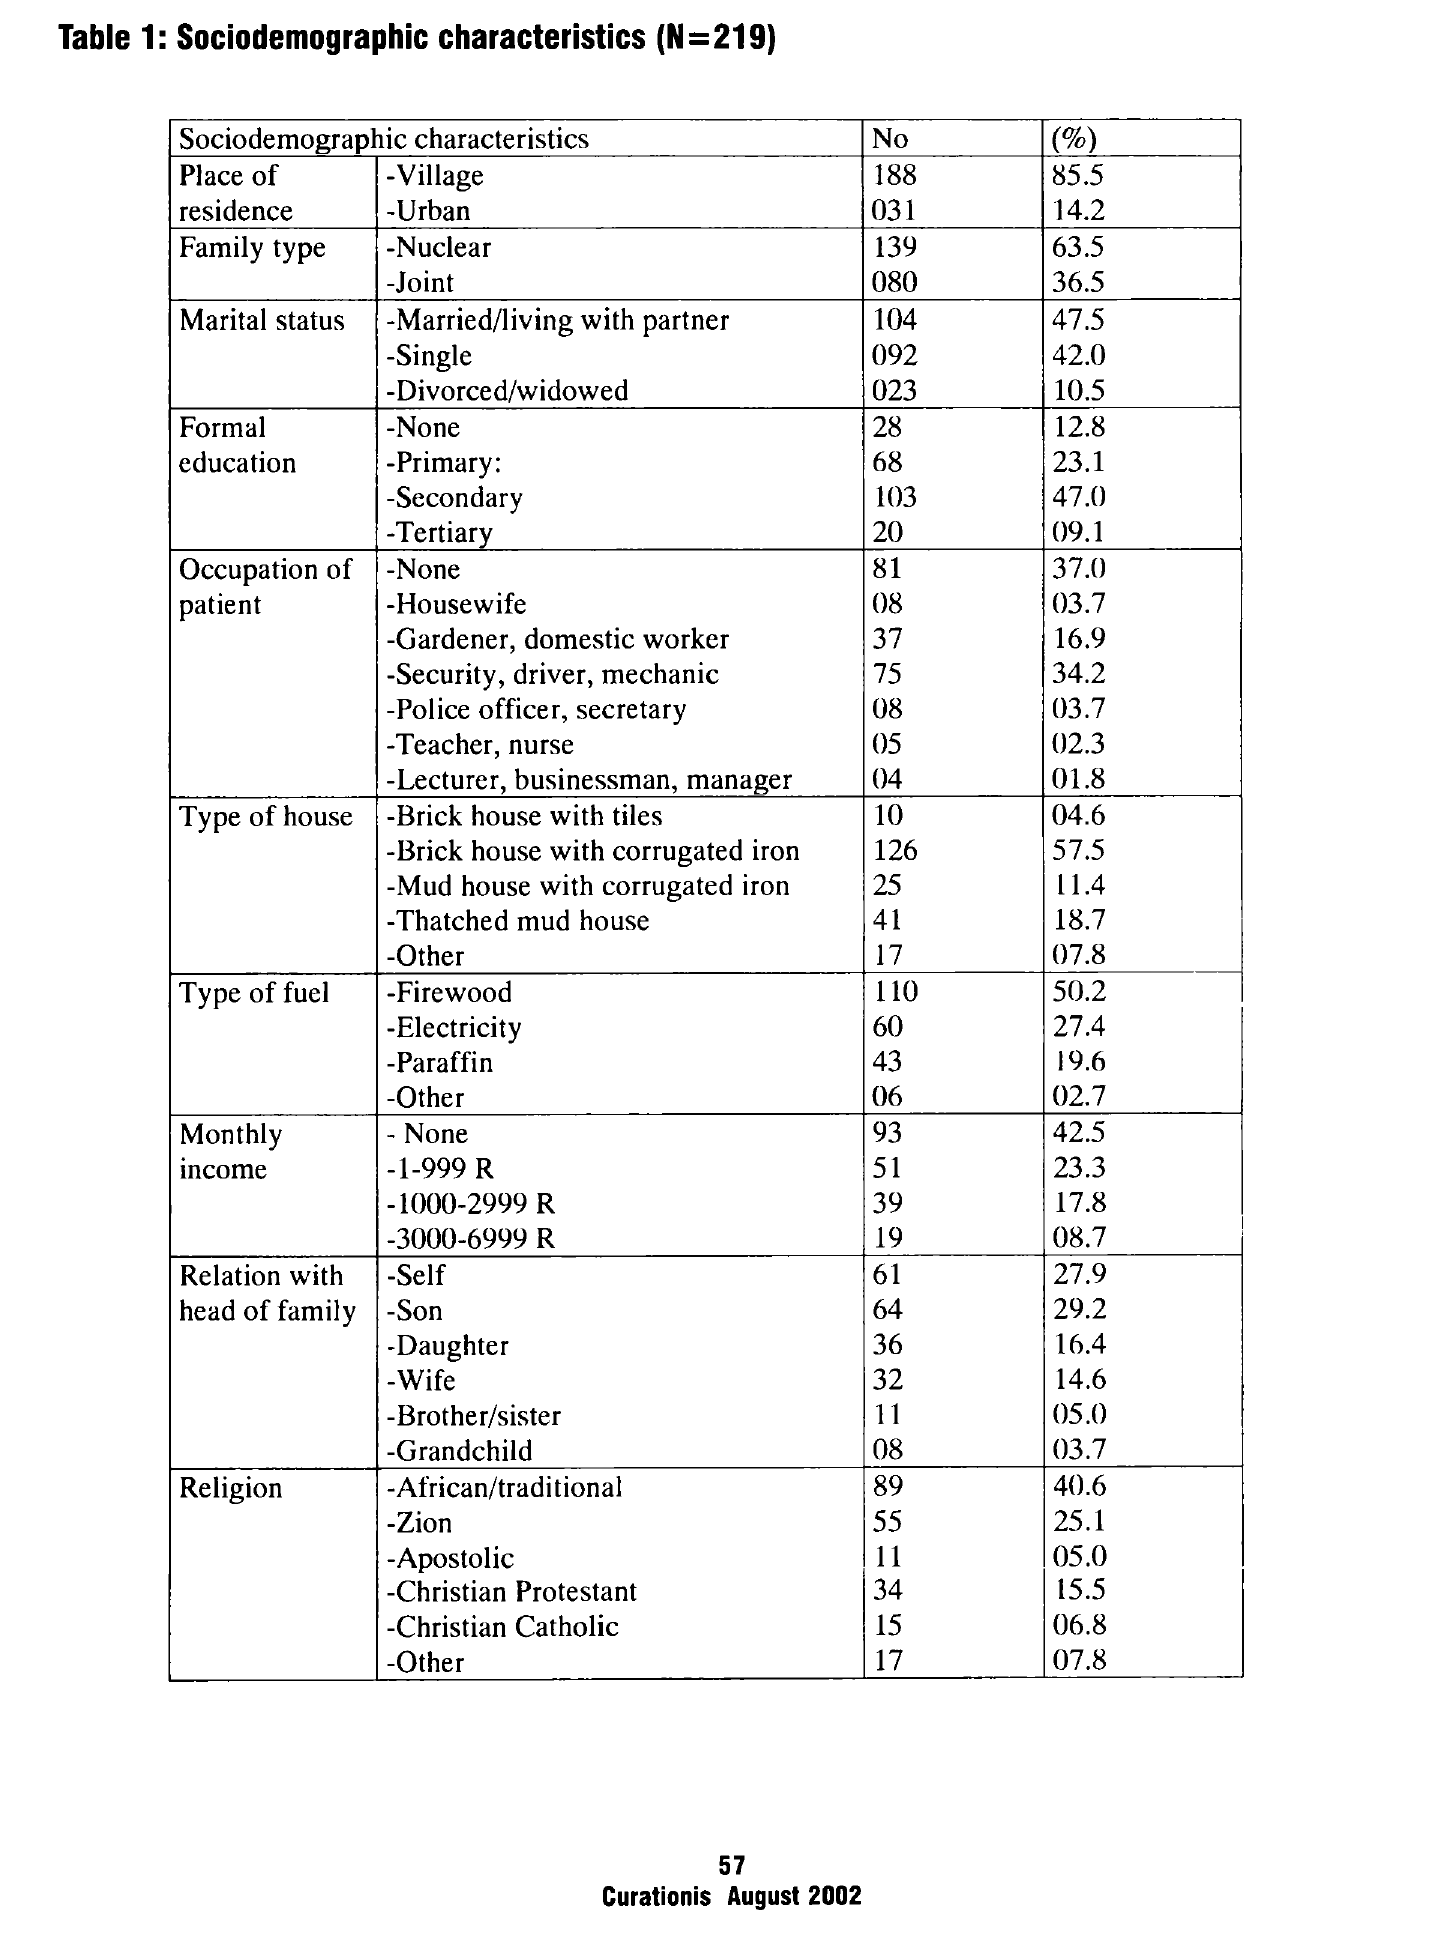
Sociodemograp]lie